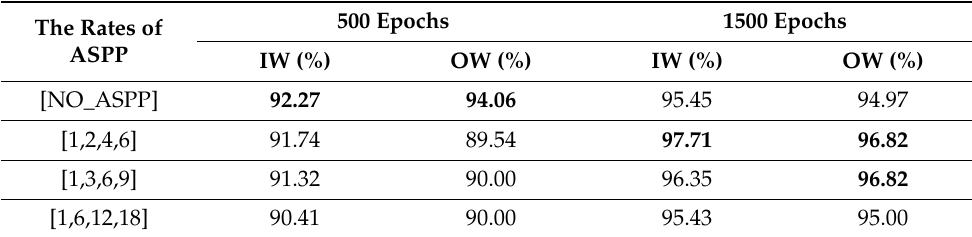
Table 1. Grasp accuracy of different rates of